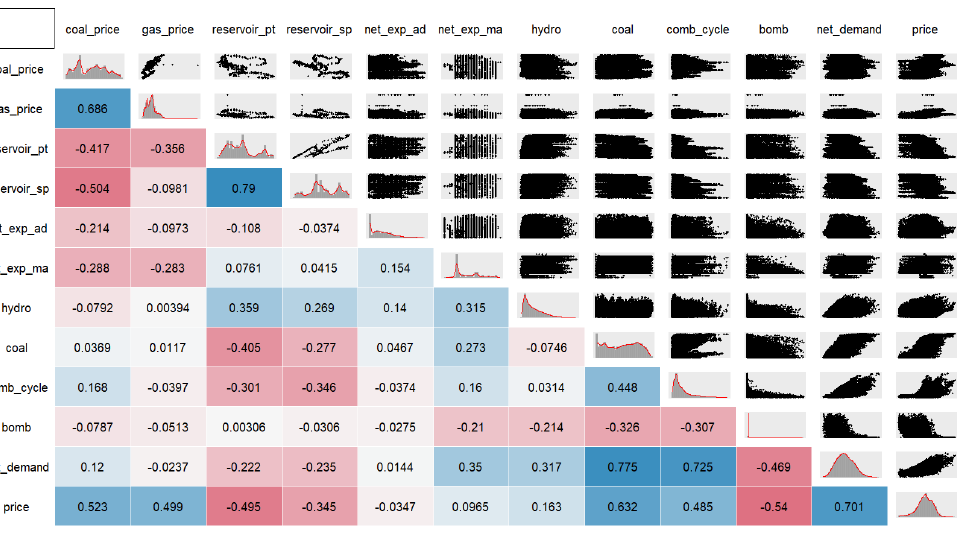
Figure 1. Correlation values in the lower corner, scatter plots in the upper corner and histograms with density in the diagonal for all possible time series to be used in this